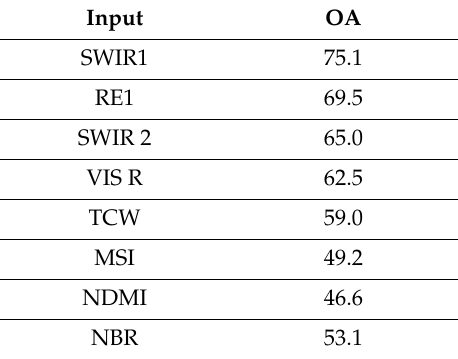
Table 3. Accuracy assessment of break dates (changes) detected using selected variables.